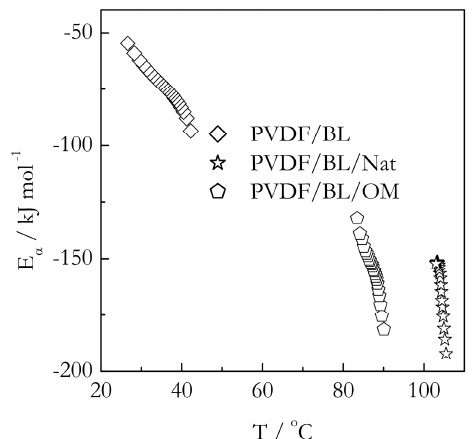
Figure 10. Temperature dependence of activation energy for gelation of PVDF/BL in bulk (diamonds) and confined systems PVDF/BL/Nat (stars) and PVDF/BL/OM (pentagons). Confinement is to 9 nm pores.